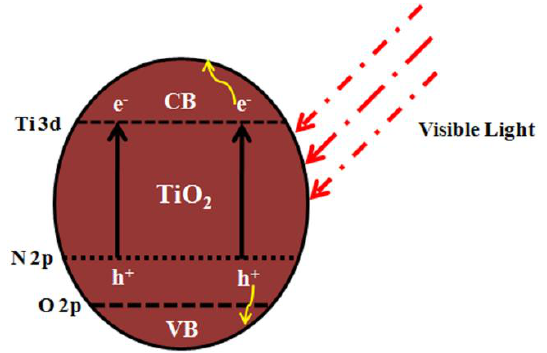
Figure 4. Creation of additional bands in NTO by